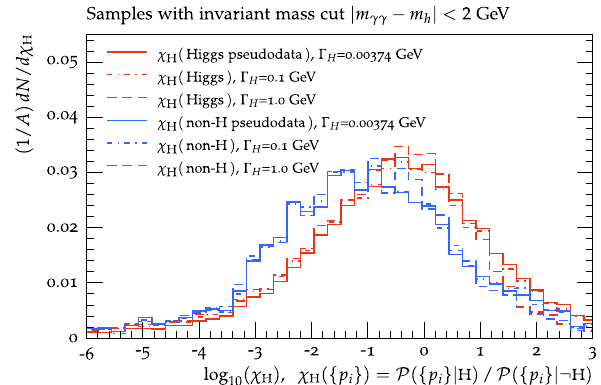
Fig. 4 Classification of signal or background pseudodata according to Higgs hypothesis, using different values of (cid:8) H . Only configurations with diphoton invariant masses in a small window are shown, to further demonstrate the discrimination power w.r.t. a simple mass cut